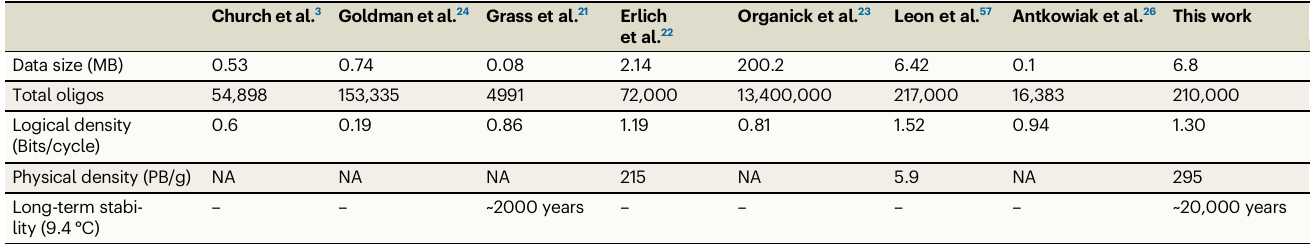
Table 1 | Key achievements of this work in comparison with prior DNA storage